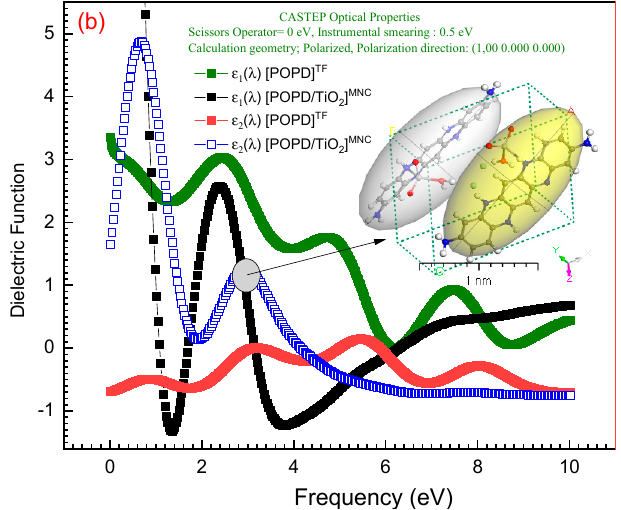
[PoPDA/TiO 2 ] MNC , σ 2 ( ω ) has a different behavior than σ 1 ( ω ), which is a result of adding Figure 10. ( a ) Experimental ε 1 and ε 2 versus h ν plots, ( b ) ε 1 and ε 2 simulation optical properties using Figure 10. ( a ) Experimental ε 1 and ε 2 versus h ν plots, ( b ) ε 1 and ε 2 simulation optical properties TiO 2 nanoparticles. Simulated data using DFT-CASTEP simulations in Figure 11b are CASTEP method in DFT for [PoPDA] TF and [PoPDA/TiO 2 ] MNC. using CASTEP method in DFT for [PoPDA] TF and [PoPDA/TiO 2 ] MNC . found to strongly match the experimental data